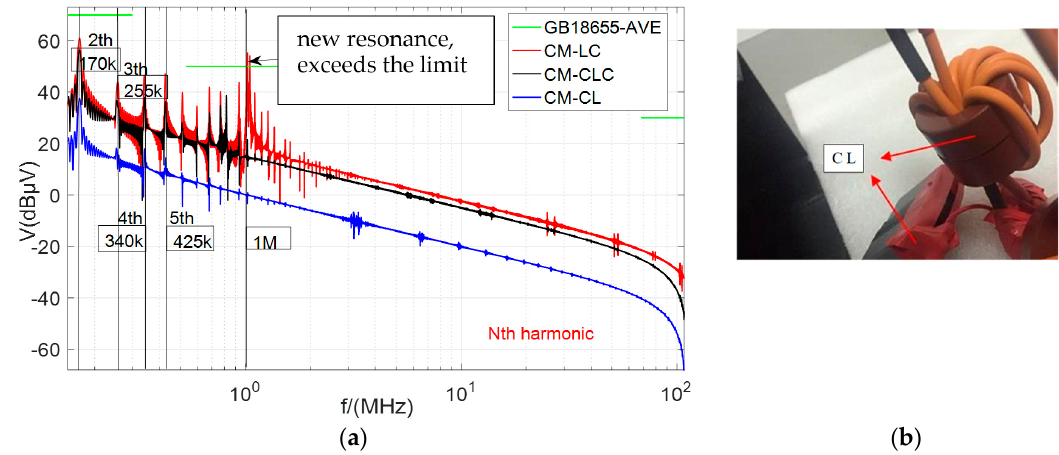
Figure 20. EMI filters ( a ) Comparison of different topologies; ( b ) Designed CL filter.